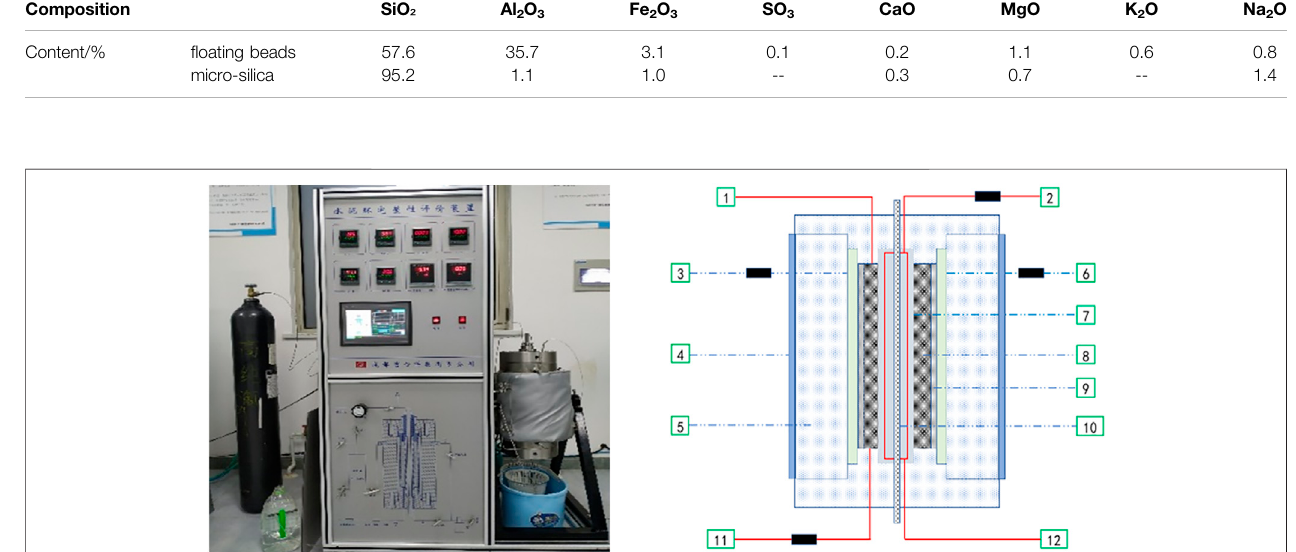
FIGURE 2 | Mechanical integrity evaluation device of the cement ring and its equivalent schematic